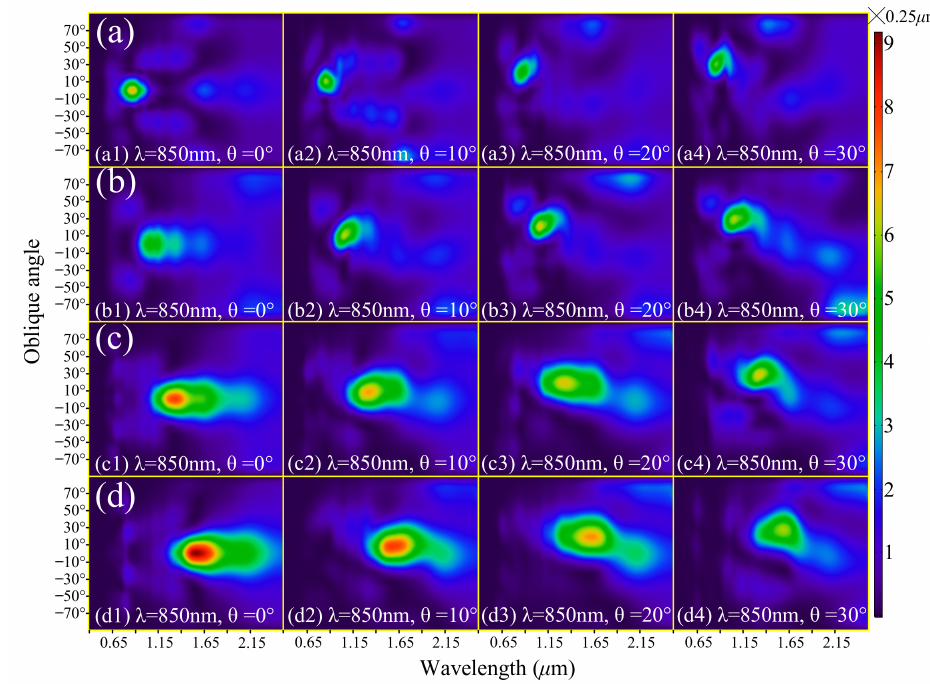
Figure A6. Effective-aperture spectra as the function of the wavelength and oblique angle, for the nanoantennas shown in Figure